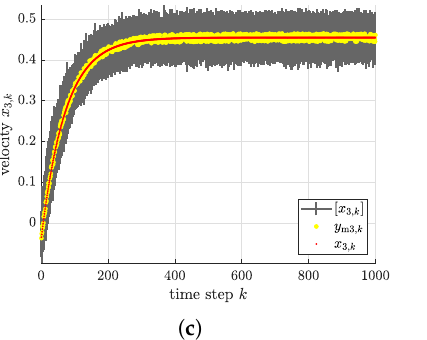
(cid:2) (cid:3) d 3, k vs. true